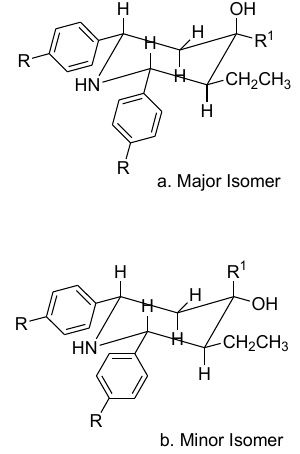
Figure 1. Isomeric forms of compounds 7-12